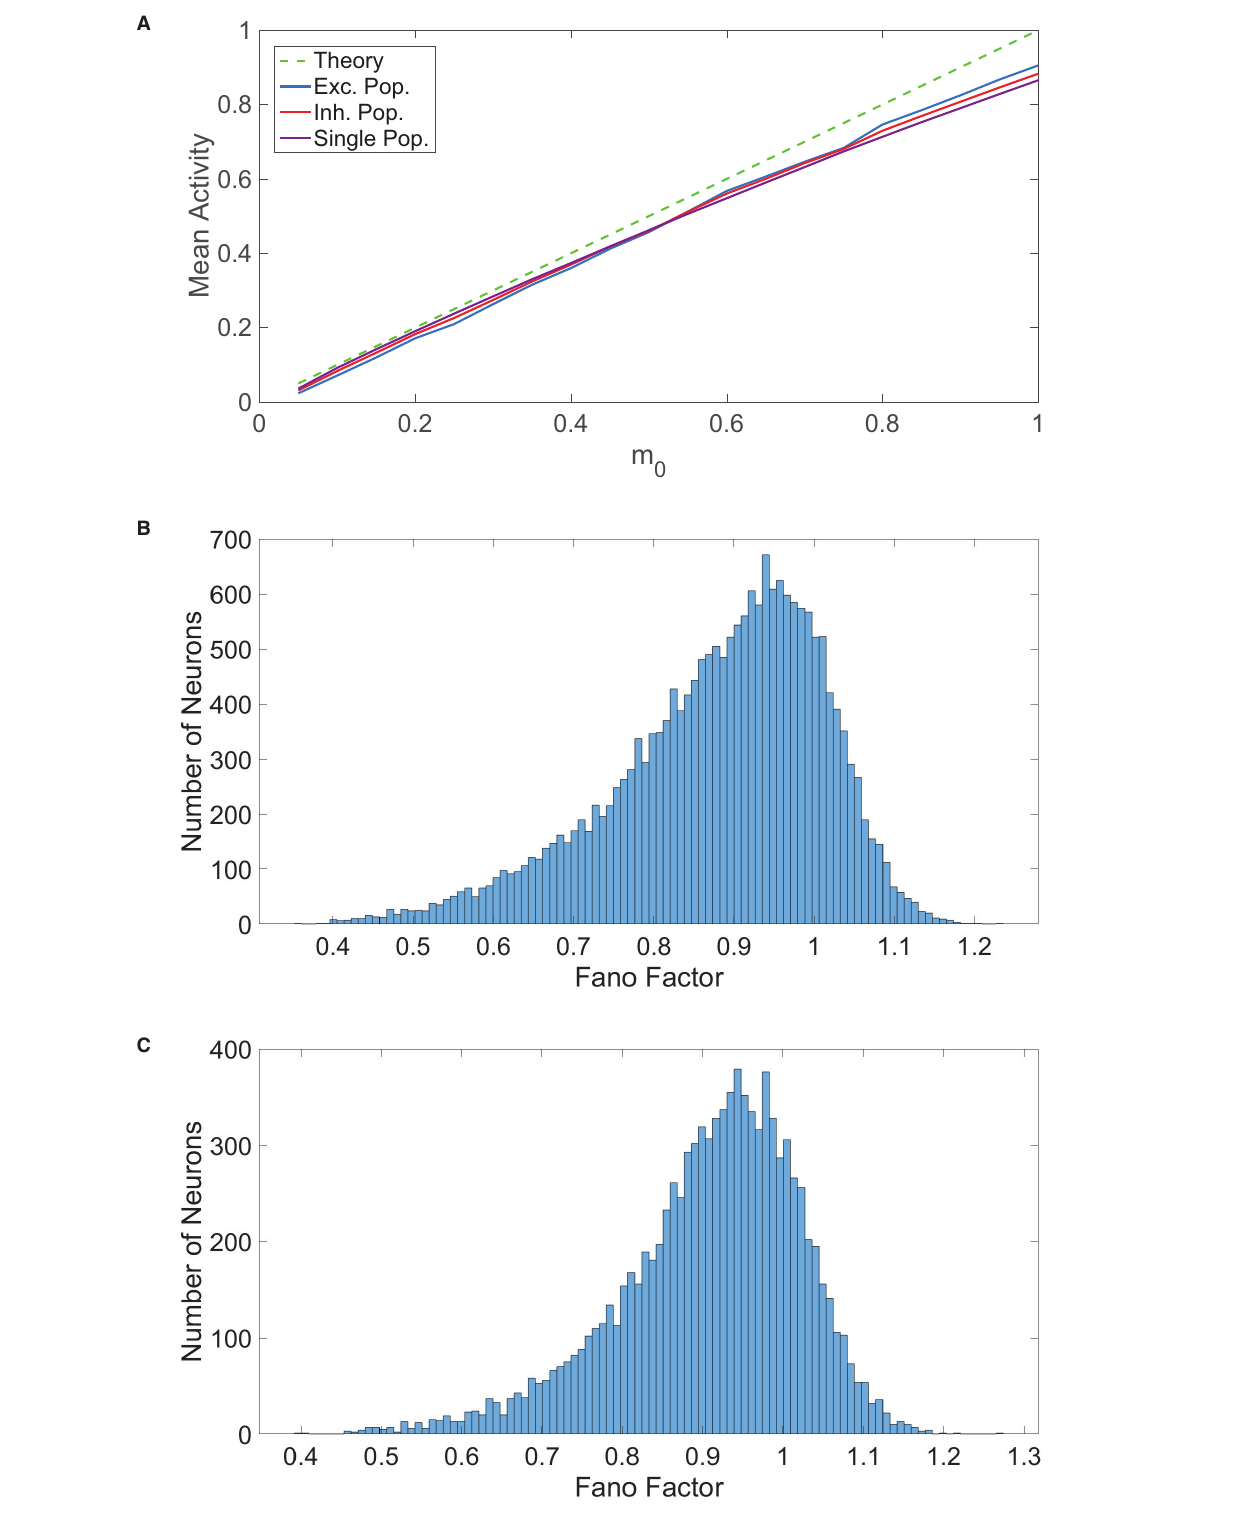
FIGURE 3 | Comparison of balanced network dynamics. (A) The mean activity averaged over a long time horizon for various choices of external input strength m 0 , plotted for the excitatory (blue), inhibitory (red), and single (purple) populations. This is compared to the expected mean activity curve from balanced network theory in